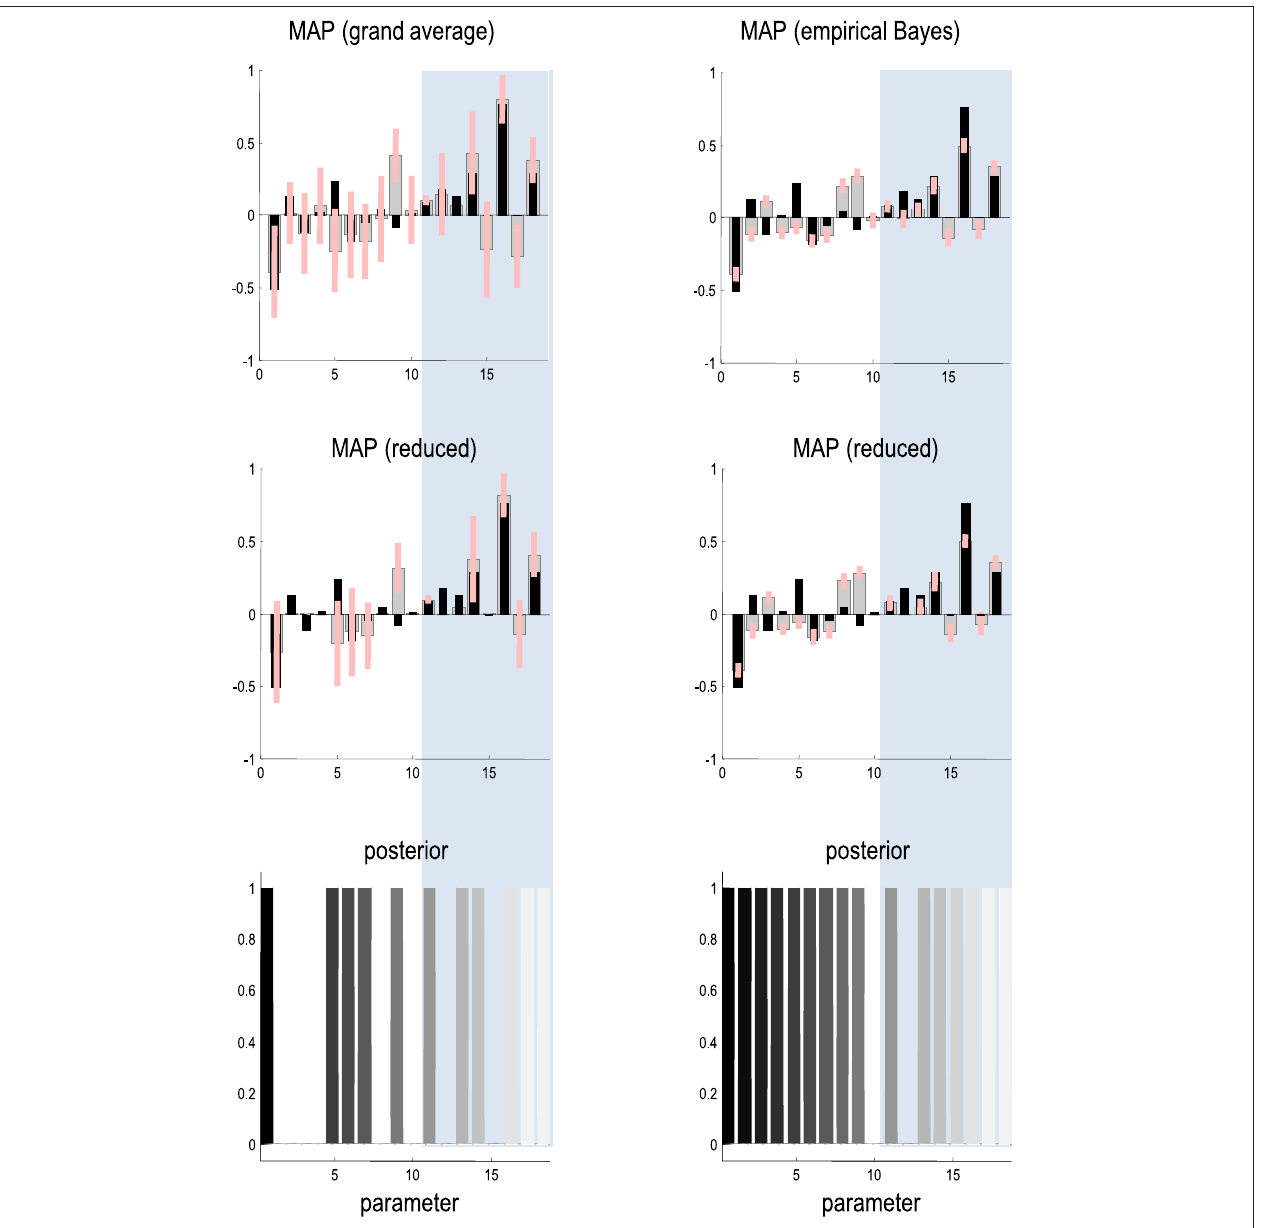
FIGURE 5 | This figure compares the posterior estimates of group means based upon the grand average (left panels) and the empirical Bayesian estimators (right panels). The top row shows the estimates prior to model reduction, while the second row shows the same results after redundant parameters have been eliminated. The gray bars correspond to conditional expectations, while the pink bars denote 90% Bayesian confidence intervals. These are superimposed on the true values, shown as black bars. The first 10 parameters correspond to the underlying connectivity (right panel in Figure 2 ), while the final eight parameters (in the shaded regions) correspond to condition specific changes mediating the mismatch negativity (left panel in Figure 2 ). The lower row reports the posterior probability of models containing each parameter, compared to models that do not (following an exhaustive model search over all combinations of the reported